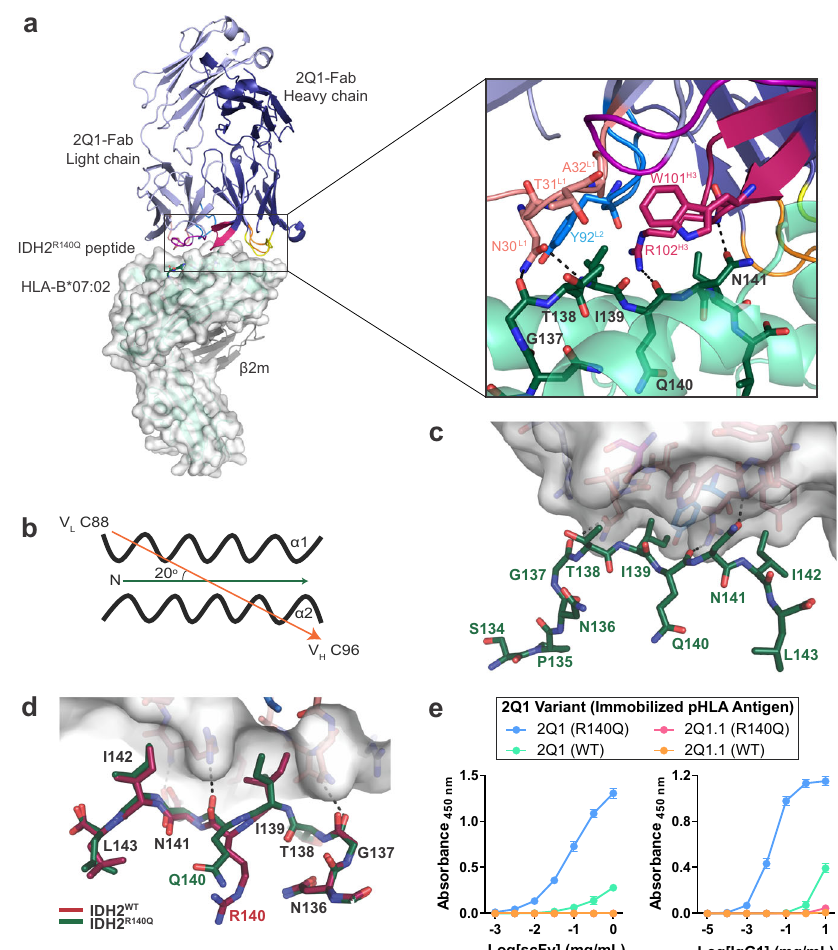
Fig. 3 Structural determinants of 2Q1 selectivity for IDH2 R140Q -HLA-B*07:02. a Overall structure of the 2Q1-Fab bound to IDH2 R140Q -HLA-B*07:02 (PDB ID 6UJ9). The HLA is shown in green cartoon and white surface. β 2-microglobulin is shown as gray cartoon. The 2Q1-Fab light and heavy chains are shown in light and deep blue, respectively, with each of the CDR loops colored as follows: L1 — salmon, L2 — purple, L3 — blue, H1 — yellow, H2 — orange, H3 — raspberry. Detailed interaction of the IDH2 R140Q peptide (aa Gly 137 -Asn 141 ) with 2Q1-Fab CDR-L1, -L2, and -H3 is shown with a black box. Zoomed view shows interacting residues represented as sticks and hydrogen bonds represented as dashed lines. b Schematic representation of the 2Q1-Fab orientation angle. The docking angle was calculated using the web server TCR3d which was based on the C alpha of Cys88 of the disul fi de bond of the V L domain and the C alpha of Cys96 of the disul fi de bond of the V H domain of the 2Q1-Fab. The arrowed line indicates the direction of orientation. c Binding of the CDRs to the IDH2 R140Q -HLA-B*07:02 complex. The 2Q1-Fab is shown in surface representation and the IDH2 R140Q peptide as sticks. CDRs are colored as in ( a ). d Structural alignment of the IDH2 WT -HLA-B*07:02 (PDB ID 6UJ8, raspberry) and 2Q1-Fab/IDH2 R140Q -HLA-B*07:02 (PDB ID 6UJ9, green) structures, showing the interactions between the peptides and 2Q1-Fab. The 2Q1-Fab is shown in white surface with key residues shown as sticks. Hydrogen bonds are depicted as dashed lines. e Binding of 2Q1 and 2Q1.1 scFvs or IgG1s to IDH2 R140Q or IDH2 WT pHLA monomers were assessed by ELISA. Data represent the mean of three technical replicates ± SD. Source data are provided as a Source data fi